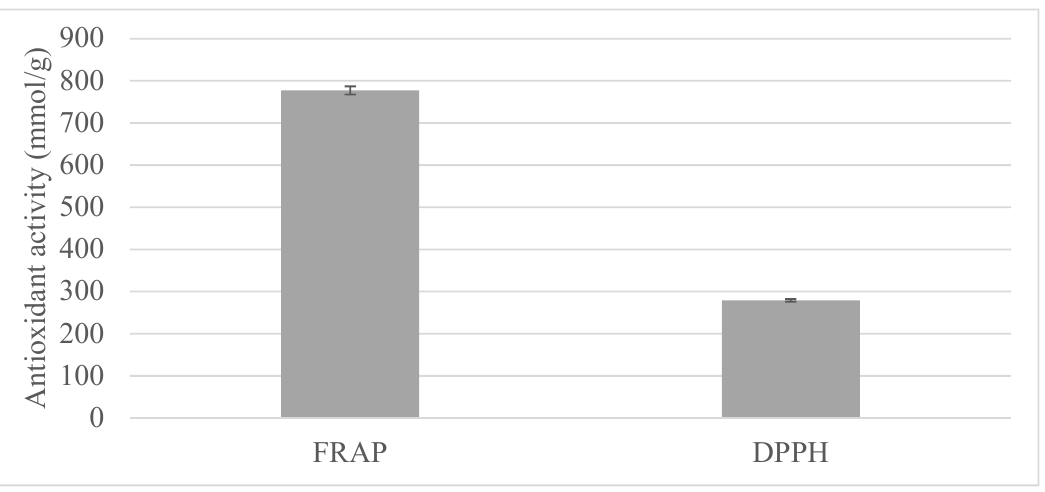
0 Figure 4. Antioxidant activity of borage ( Echium amoenum ) flowers obtained in the optimum conditions.